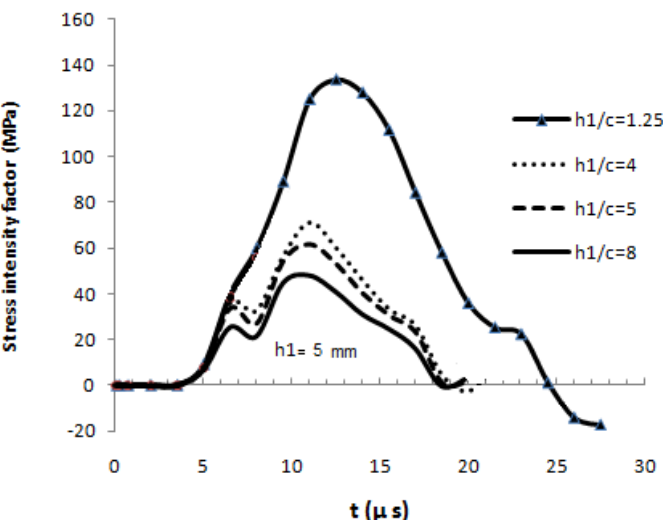
Figure 5. DSIF curves versus time of PZT-4 composite.